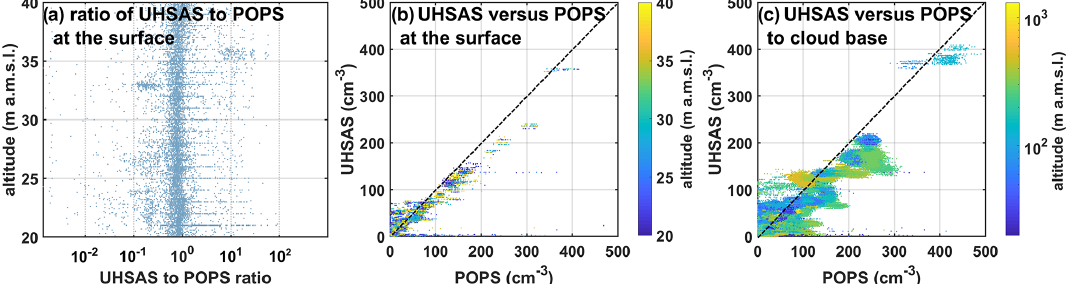
Figure 4. (a) The ratio of UHSAS to POPS aerosol number concentrations in the overlapping size range (130–1000nm) and on the ground (defined as 20–40ma.m.s.l.) versus altitude from all flights. Scatterplots of UHSAS versus POPS aerosol number concentrations for (b) mea- surements on the ground and (c) from the ground to cloud base (cloud base altitude varied for each flight). Data for (b) and (c) are colored by altitude (note the different scales for each panel). Dashed lines show the 1 : 1